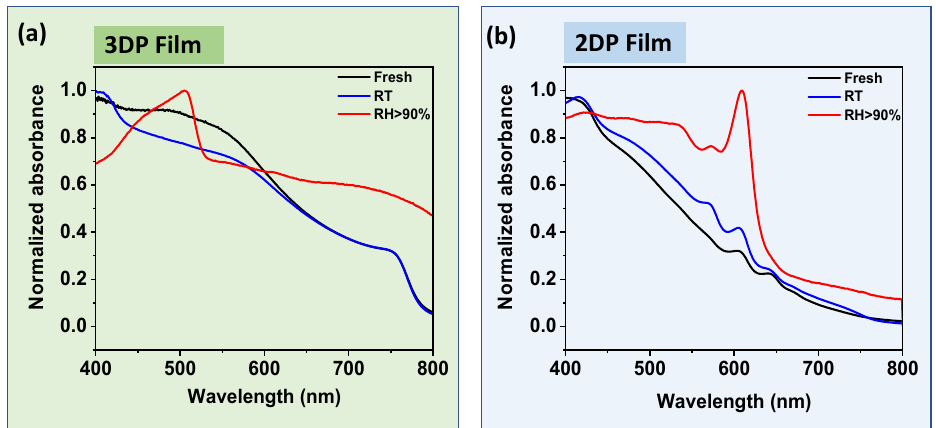
Figure 7. UV ‐ vis optical absorption measurements on spin coated ( a ) 3DP and ( b ) 2DP films on top of FTO substrates at the three conditions noted in the caption of Figure 5. The onset of the optical absorption edge for the 3DP freshly synthesized film at t = 0 occurs at ~775 nm in ( a ), while this absorption edge starts at a shorter λ , less than 700 nm for the 2DP film in ( b ). For the RT exposed 3DP samples in ( a ), there is already a reduction in the absorbance below 625 nm, while for the RT exposed 2DP samples in ( b ), an improvement in the absorbance is seen for all wavelengths in the measurement range below the optical absorption edge, i.e., <700 nm. For the 3DP exposed to RH, there is once again a general reduction in the optical absorption based on the intensity, and a sharp rising edge occurs at λ < 525 nm which maybe attributable to the breakdown of the 3DP film into PbI 2 which is optically active at shorter λ , closer to the near ‐ UV region. Equivalently, for the 2DP film, several optical resonances surface between 550–650 nm at all of the three environmental conditions examined, which are not present in the spectra of the 3DP film. The optical resonances in the 2DP films may be attributable to quantum confinement and excitonic effects given the reduced physical dimension of the 2DP crystalline structure.